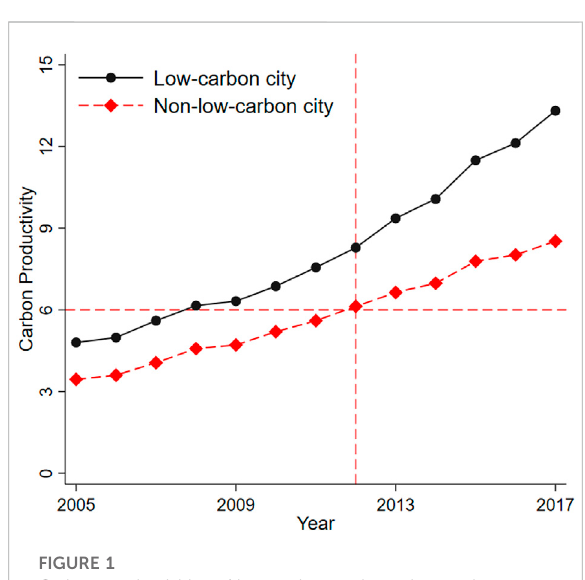
FIGURE 1 Carbon productivities of low-carbon and non-low-carbon